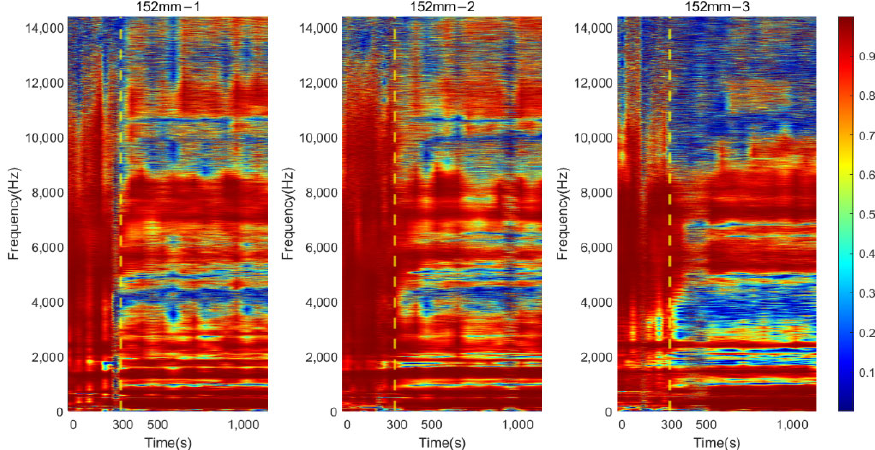
Figure 4. Coherence function for residual length of 152 mm.